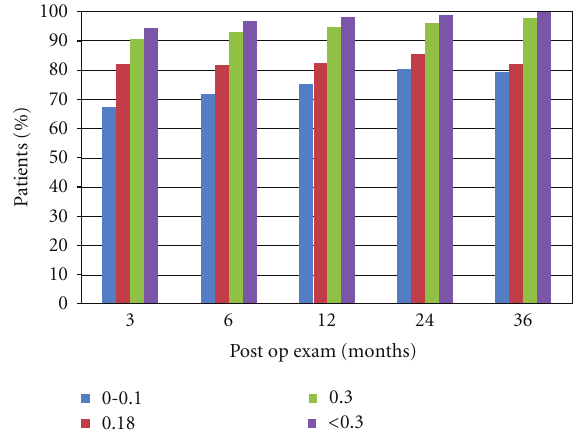
Figure 1: UDVA in di ff erent periods of followup.